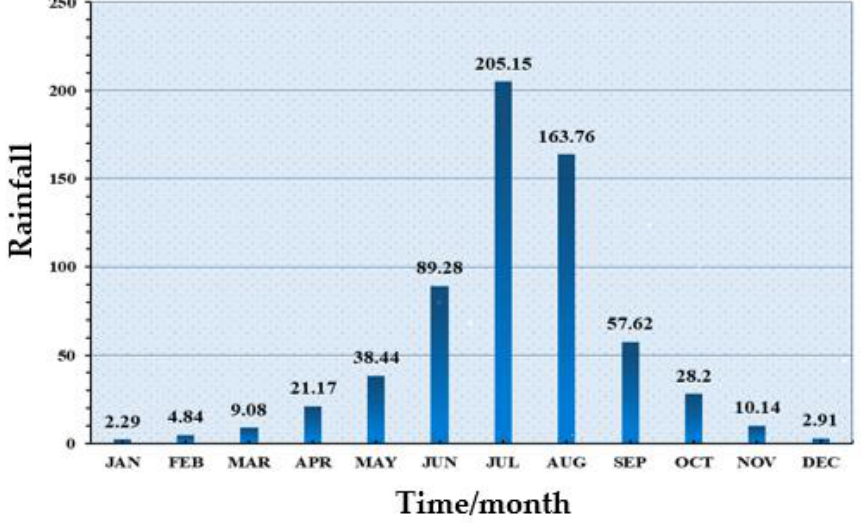
Figure 2. Average monthly rainfall data (from 1959 to 2017) for the Pinggu district.